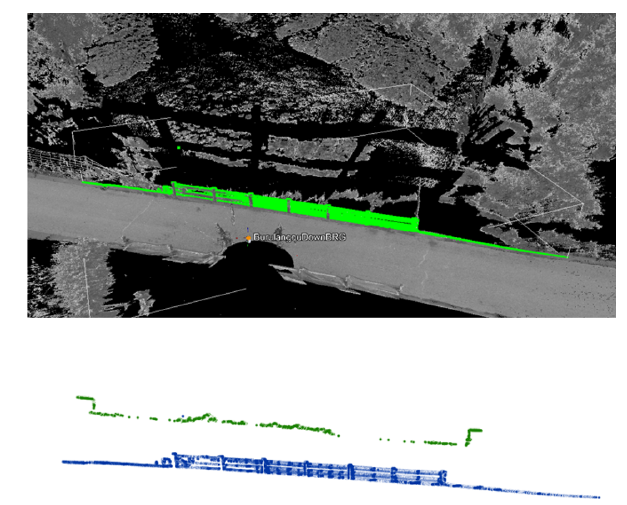
Figure 4. Elevation points cloud scanned by Rigel VZ1000.